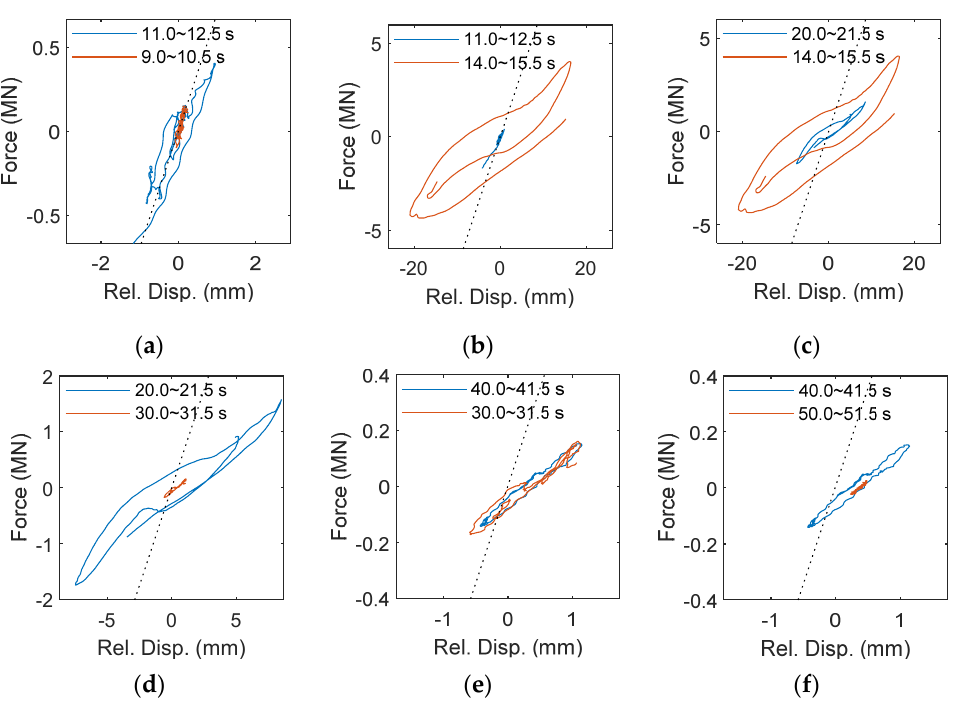
Figure 12. The identification result of the 10-story RC frame during the shaking table test. ( a ) Ground excitation and structural responses; ( b ) identified modal frequencies over time (the gray grids indicate the results identified from the white-noise excitaitons).